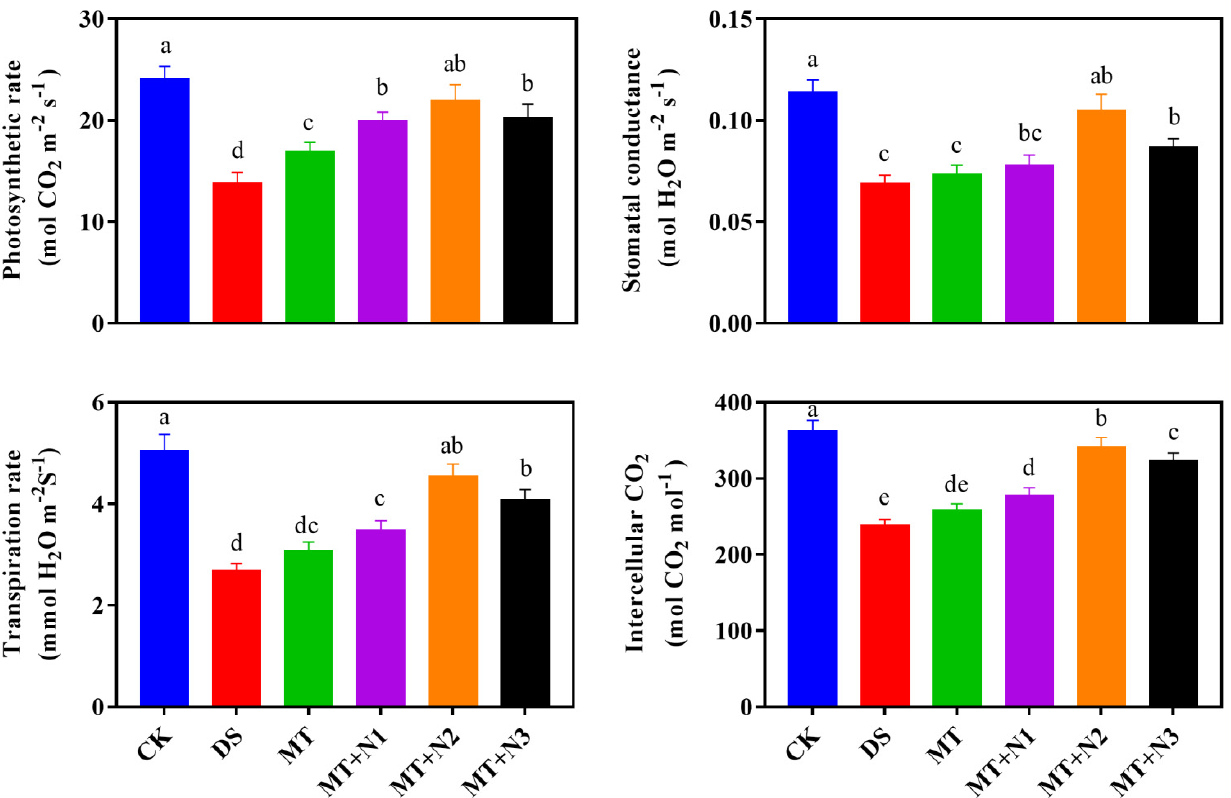
Figure 4. Photosynthetic gas exchange of maize seedlings under drought-stress conditions in combination with melatonin in different levels of nitrogen. CK; Well-watered control without melatonin (MT), DS; Drought stress without MT, MT; Drought stress + 100 µM MT, MT + N1; MT 100 µM + 200 kg N ha − 1 , MT + N2; MT-100 µM + 250 kg N ha − 1 , and MT + N3; MT-100 µM + 300 kg N ha − 1 . Vertical bars represent ± S.D. ( n = 3, biological replicates). Different letters indicate significant differences as determined by the LSD test ( p ≤ 0.05).